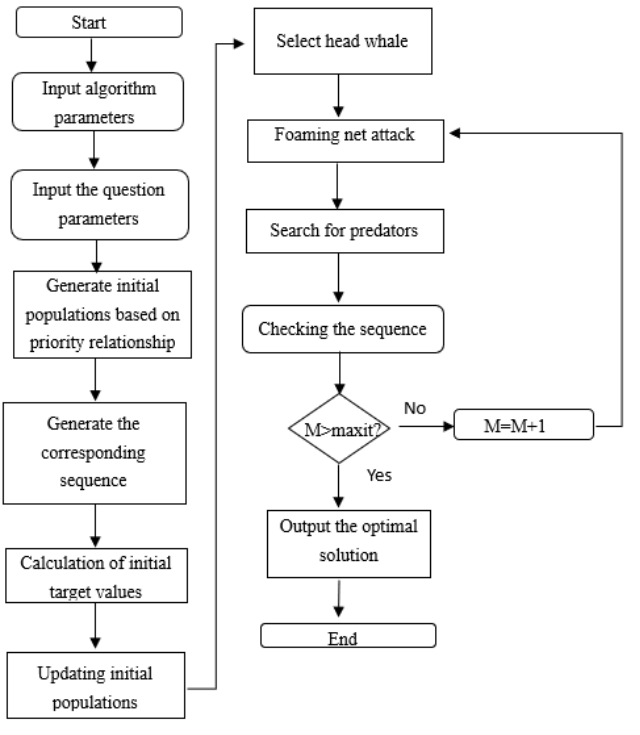
Figure 6. IWOA flow chart.